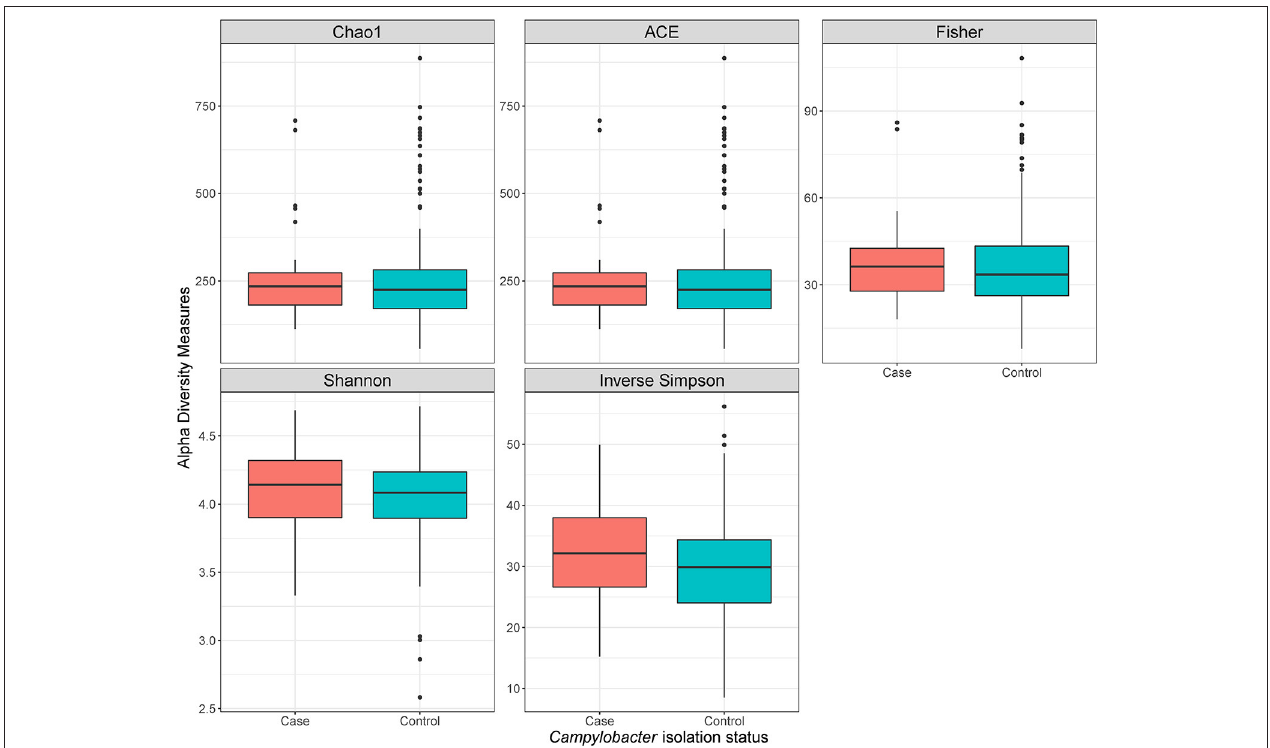
FIGURE 2 | Alpha diversity plots of composite broiler litter samples. Samples are separated by the Campylobacter isolation status of the flock. Flocks were classified as cases when either C. jejuni or C. coli was isolated in boot sock samples, or as controls otherwise.